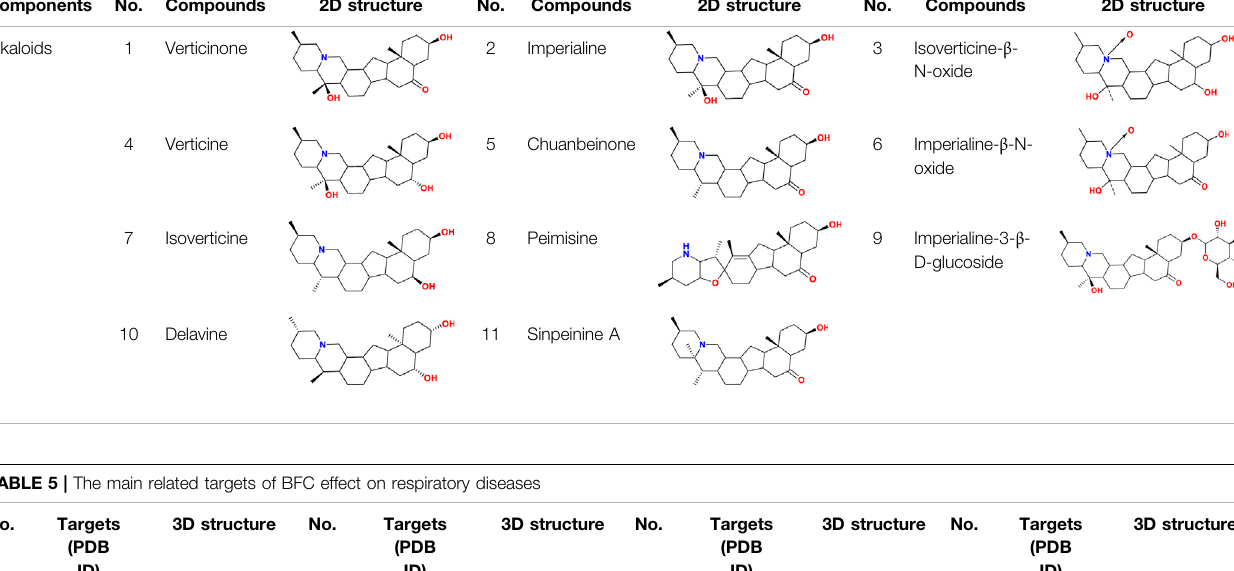
TABLE 4 | The main related compounds of BFC ’ s effect on respiratory diseases Components No. Compounds